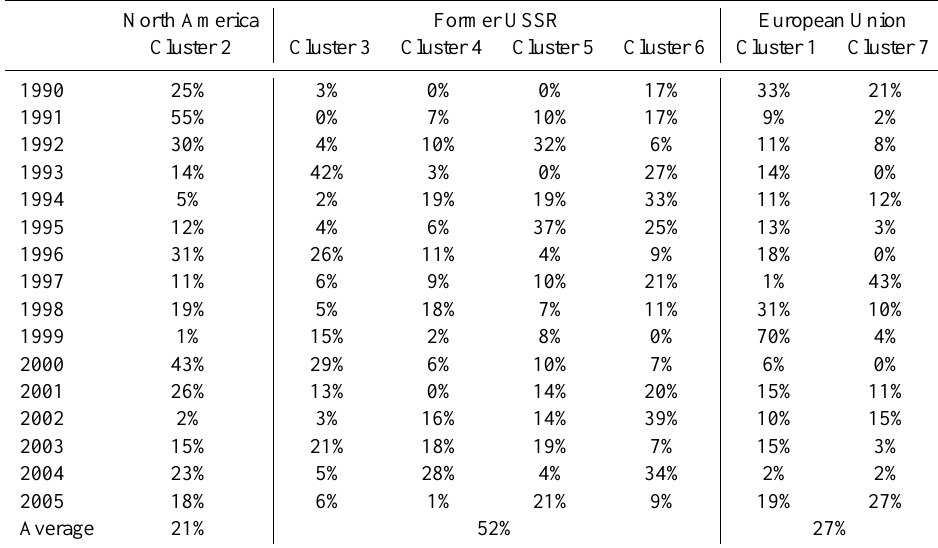
Table 1. Inter-annual variation of transport frequency (trajectory number of each sector divided by the total number of trajectories, in percentage) affecting Alert in January, 1990–2005.